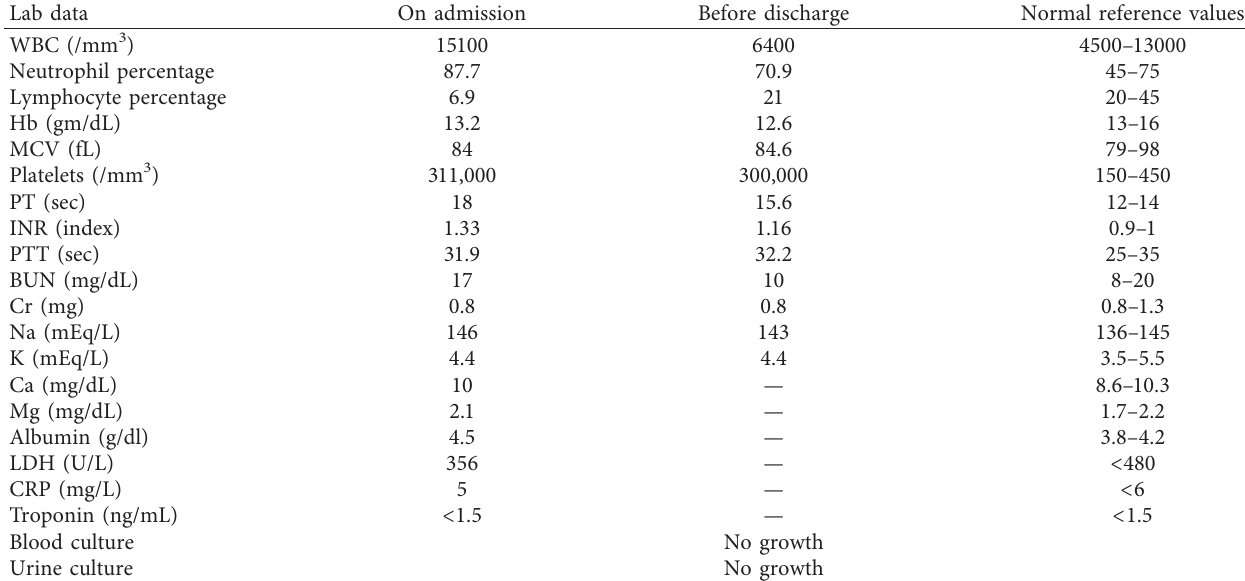
Figure 2: Chest computer tomography revealing significant emphysematous. A: pneumothorax; B: pneumomediastinum; and C: sub- cutaneous emphysema. Table 1: Paraclinical findings of the patient during her course of